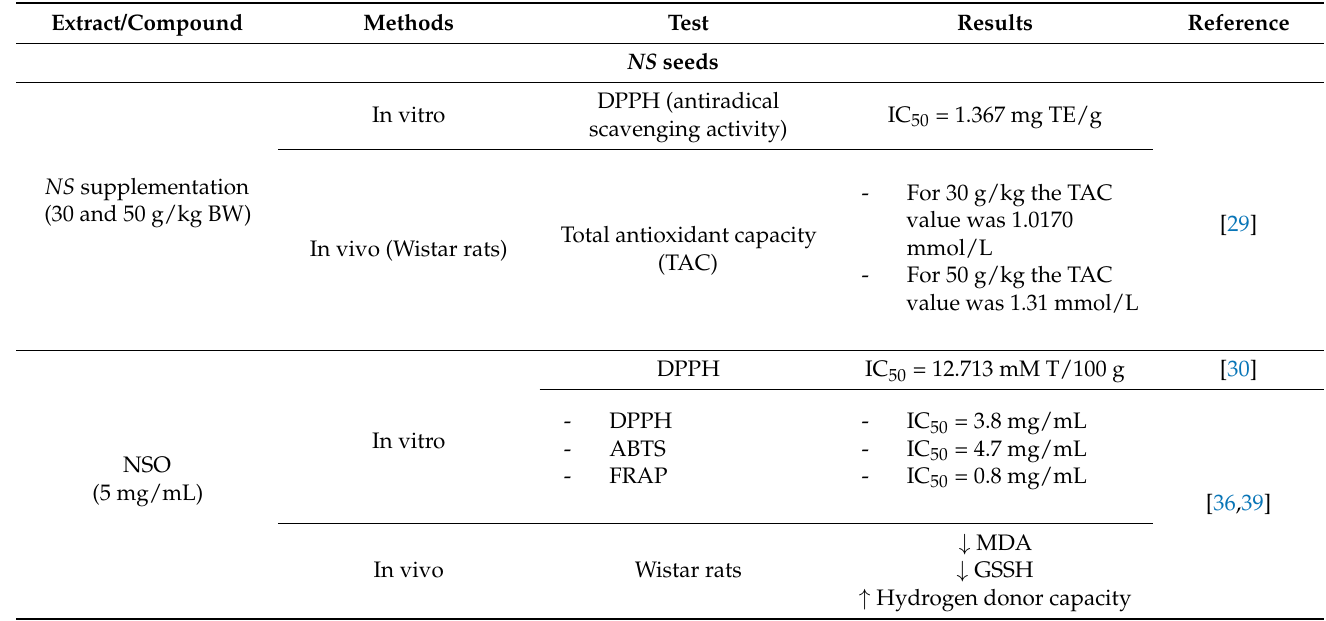
Table 1. Summary of the antioxidant activities of the